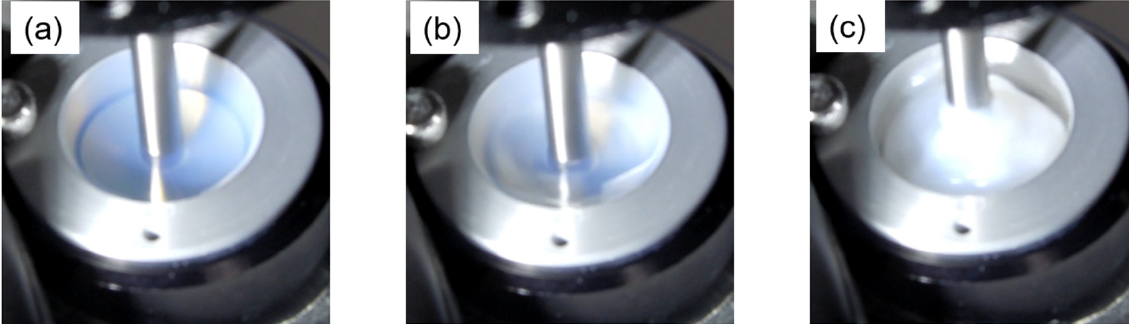
Figure 4. Time series photographs of shake-gels under applied shear by the viscometer. The molecular weight of PEO was 1000 kg/mol, and the value of C p was 0.05 mg/m 2 . The constant shear rate of 300 s − 1 was applied, shown as the symbol ( ◇ ) in Figure 3b. ( a ) At the beginning of shear (1–16 s), viscosity was decreasing. The suspension was transparent. ( b ) At medium-term shear (17–30 s), viscosity turned from decreasing to increasing. Some white gel-like segments were observed. ( c ) At the end-term of shear (after 30 s). Viscosity increased and reached a constant. Whole gelation and the Weissenberg effect were observed.